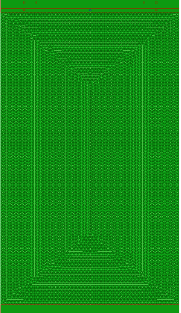
Figure 7: Geometrical model of the rectangular